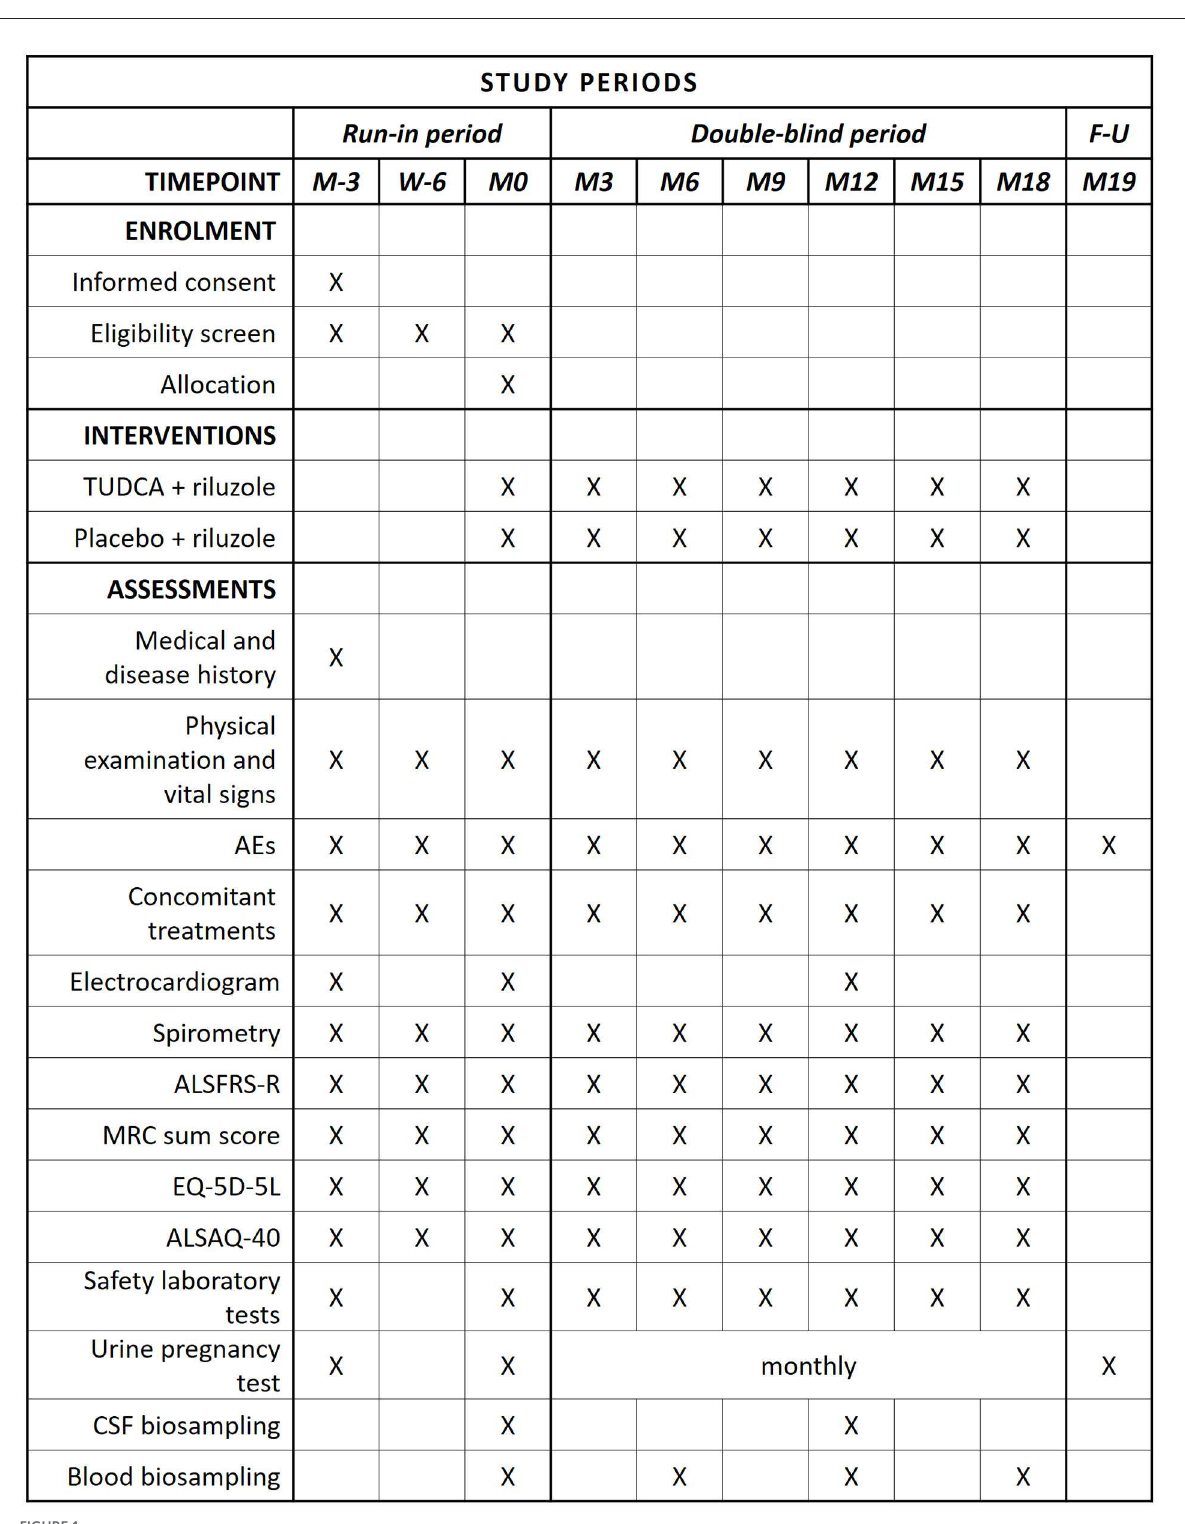
FIGURE1 SPIRIT schedule of enrollment, interventions, and assessments. In compliance with current marketing authorization for TUDCA, the following liver function parameters are monitored: AST, ALT, GGT, and bilirubin. Considering that there is yet insufficient information on possible teratogenic effects, a urine pregnancy test is performed monthly (from M0 to M18) and 30 days (1 month) after the last IMP